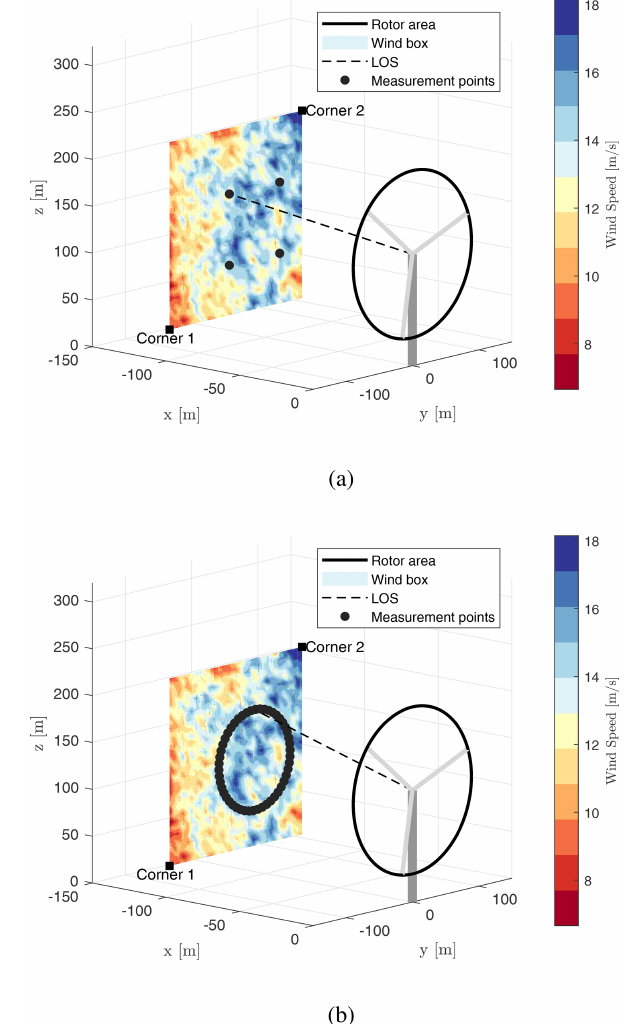
Figure 1. Coordinate system of wind box and lidar scan patterns. The wind box is shown using the color map. Two corners are marked as black squares (corner 1 and corner 2). Two commer- cial CW lidar scan patterns are shown: (a) 4-beam CW lidar and (b) 50-beam circular scan CW lidar. The dashed line represents the line-of-sight